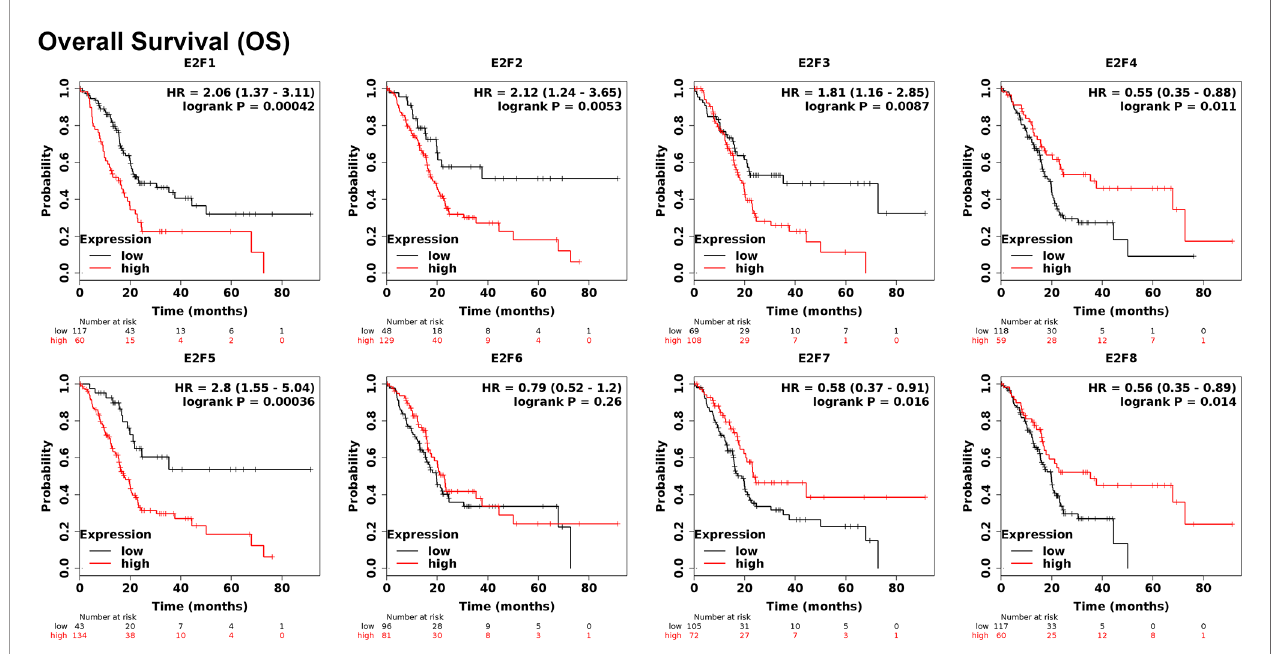
FIGURE 6 | The prognostic value of different expressed E2Fs in PAAD patients in the OS curve (Kaplan-Meier